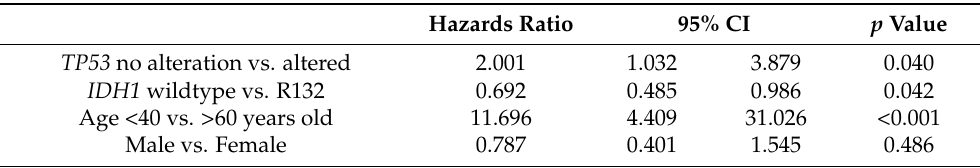
Table 7. Multivariate Cox proportional hazards analysis of TP53 status in the oligodendroglioma subgroup of TCGA-LGG dataset.